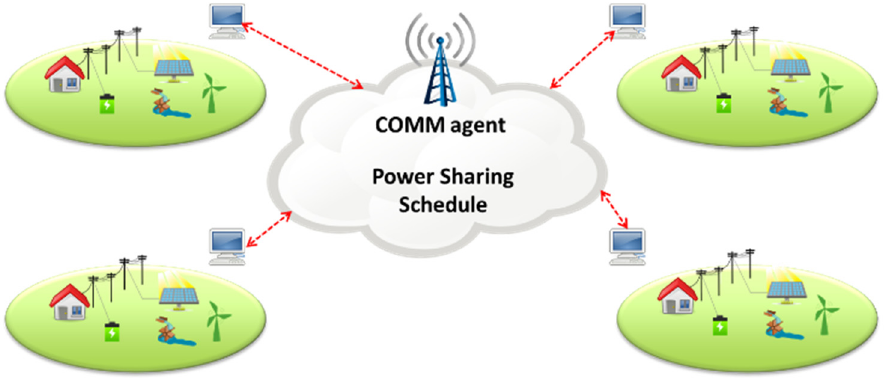
Figure 3. Communication agent structure (COMM) .